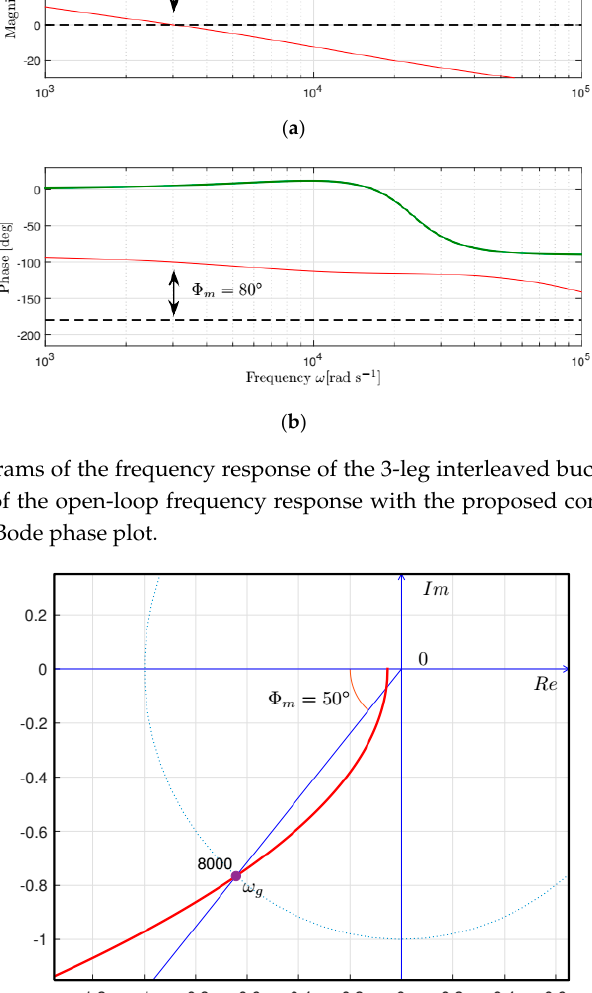
Figure 10. The Nyquist plot of the open-loop frequency response of the current control system.